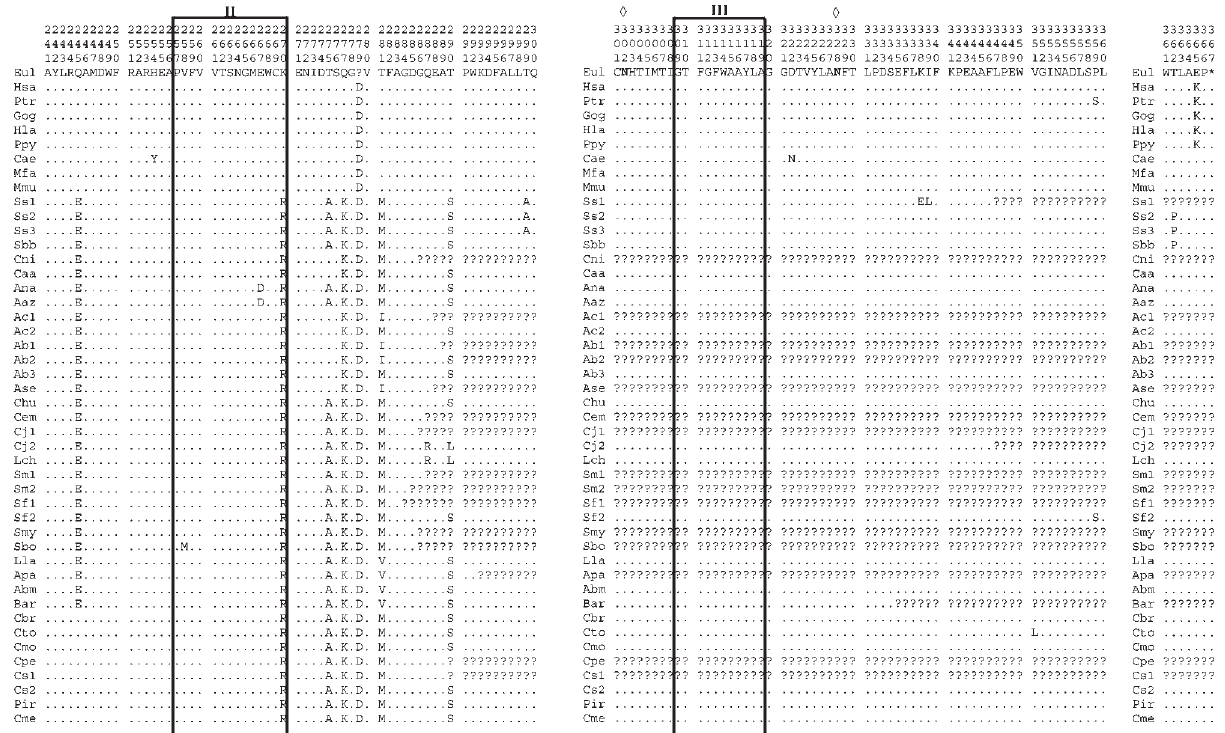
Figure 1 (cont.) - Amino acid sequence of FUT1 gene. The lozenges ( ◊ ) indicate the glycosylation sites described by Larsen et al. (1990) and Apoil et al. (2000); the box indicates the position of the transmembrane domain (TD) and of the three conserved motifs described by Oriol et al .